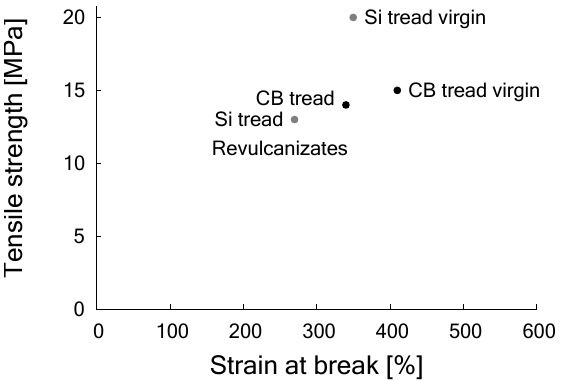
Figure 10. Tensile strength and strain at break of model compounds with 80 phr CB and 90 phr silica respectively, before and after devulcanization. (Re)vulcanization of each compound with the same formulation, see Table 8.